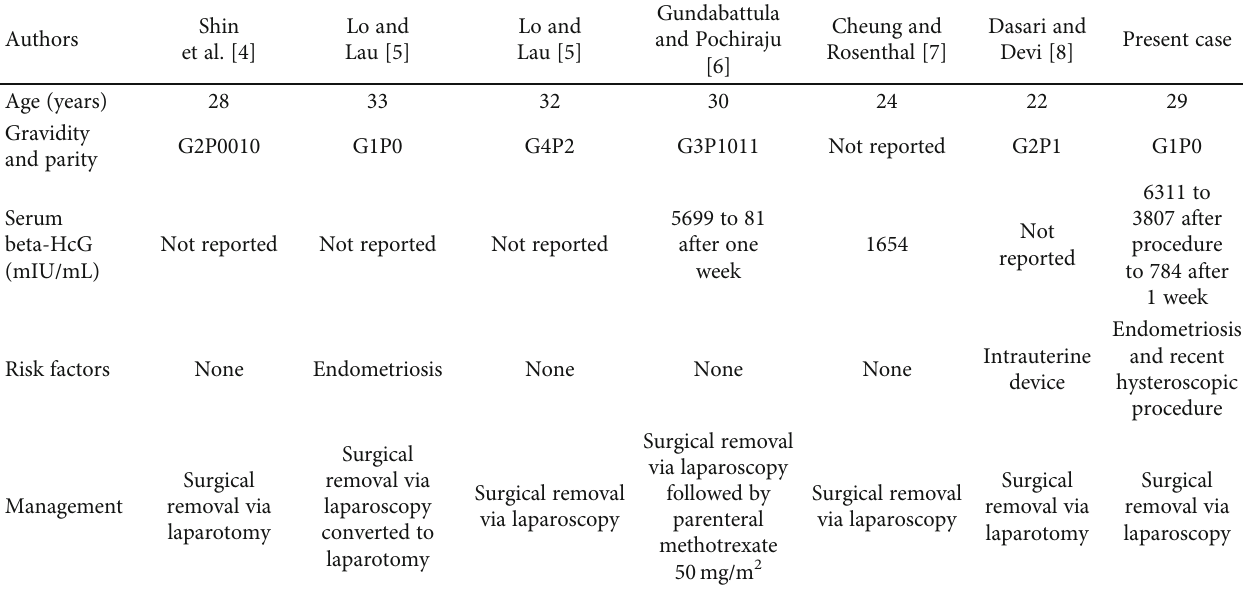
Table 1: Summary of prior cases with an ectopic pregnancy within the uterosacral